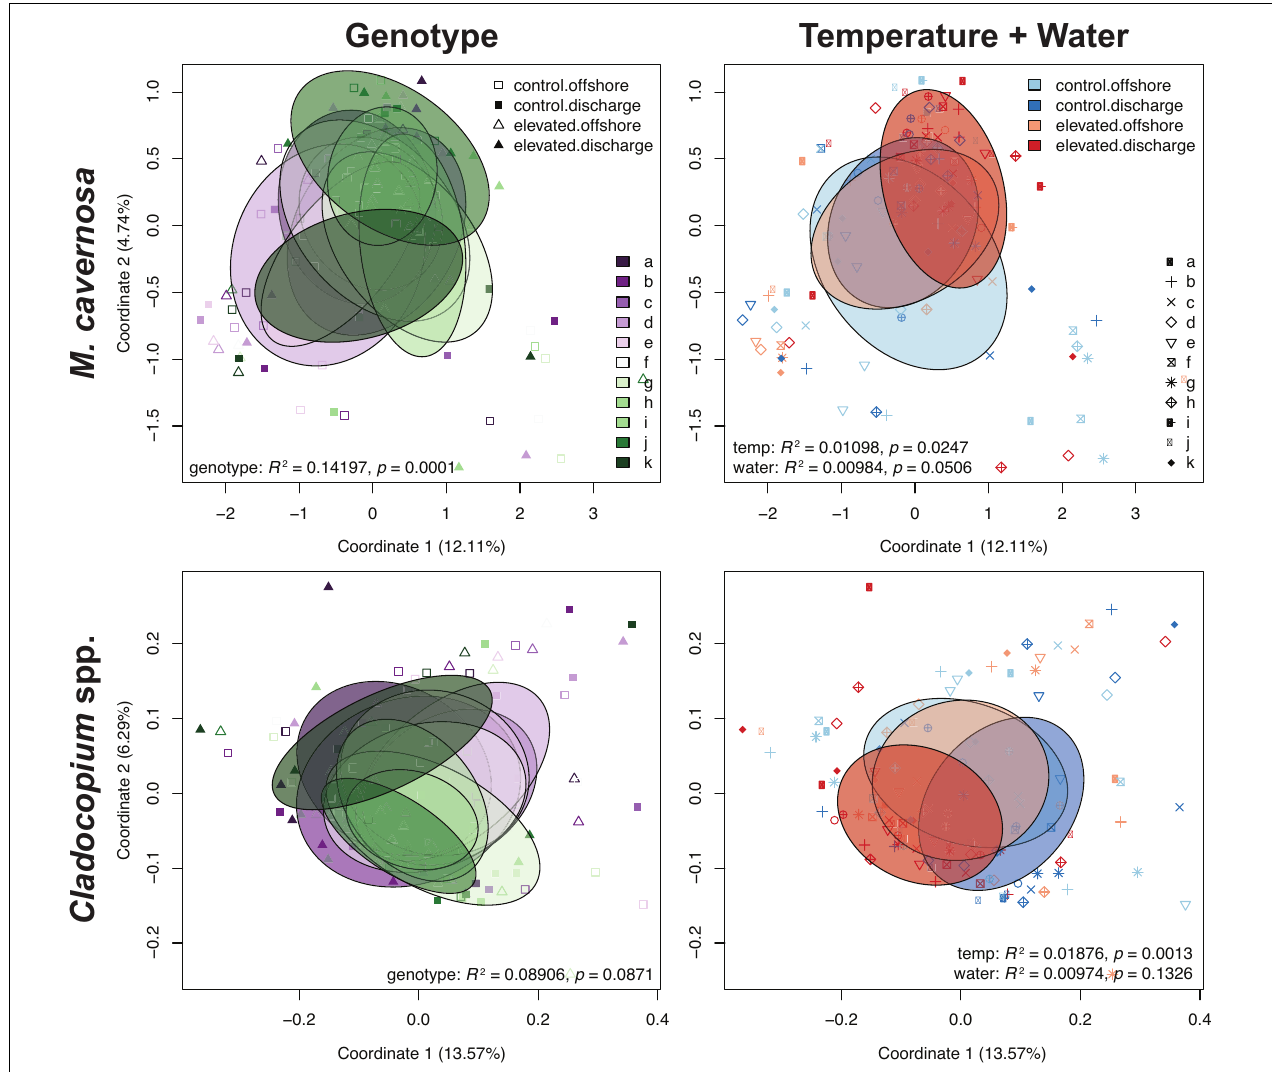
FIGURE 4 | PCoAs of coral host and symbiont datasets depicting transcriptomic variation for coral genotypes and temperature + water treatments from the ex situ experiment. Ellipses denote the dispersion of each factor’s samples. Test statistics and p values generated from PERMANOVAs in vegan .